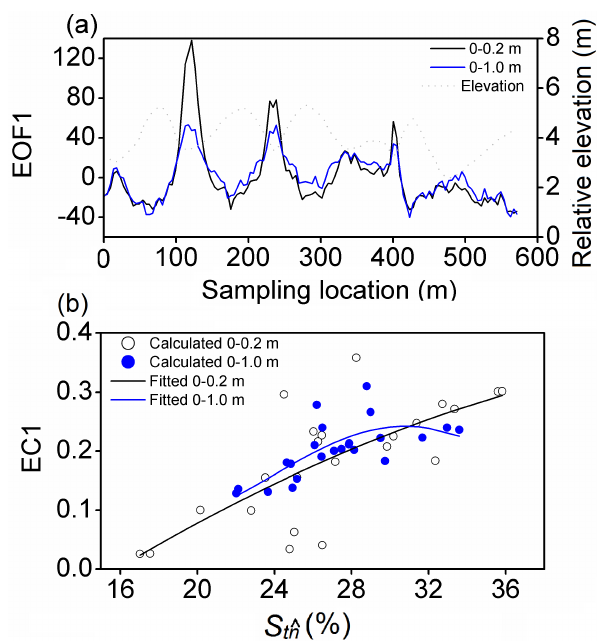
Figure 4. (a) The EOF1 of the spatial anomaly Z tn and (b) relation- ships of associated EC1 versus spatial mean soil water content Z tn fitted by the cosine function (Eq.